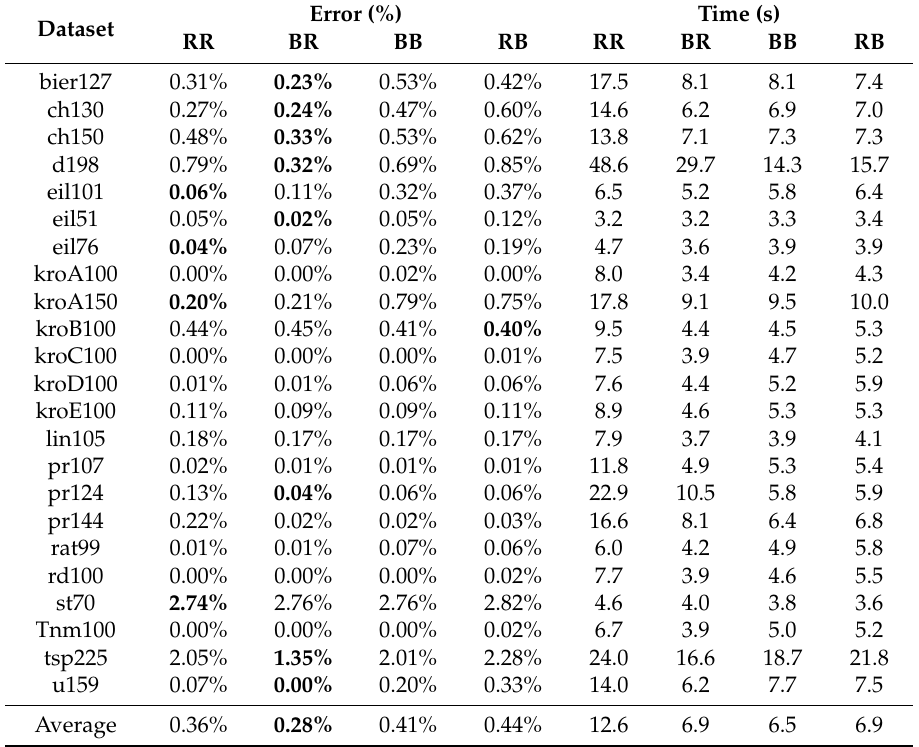
Table 1. Mean errors (%) and computations times (s) obtained for the analyzed traveling salesman (TSP) datasets solved with di ff erent sets of agents.